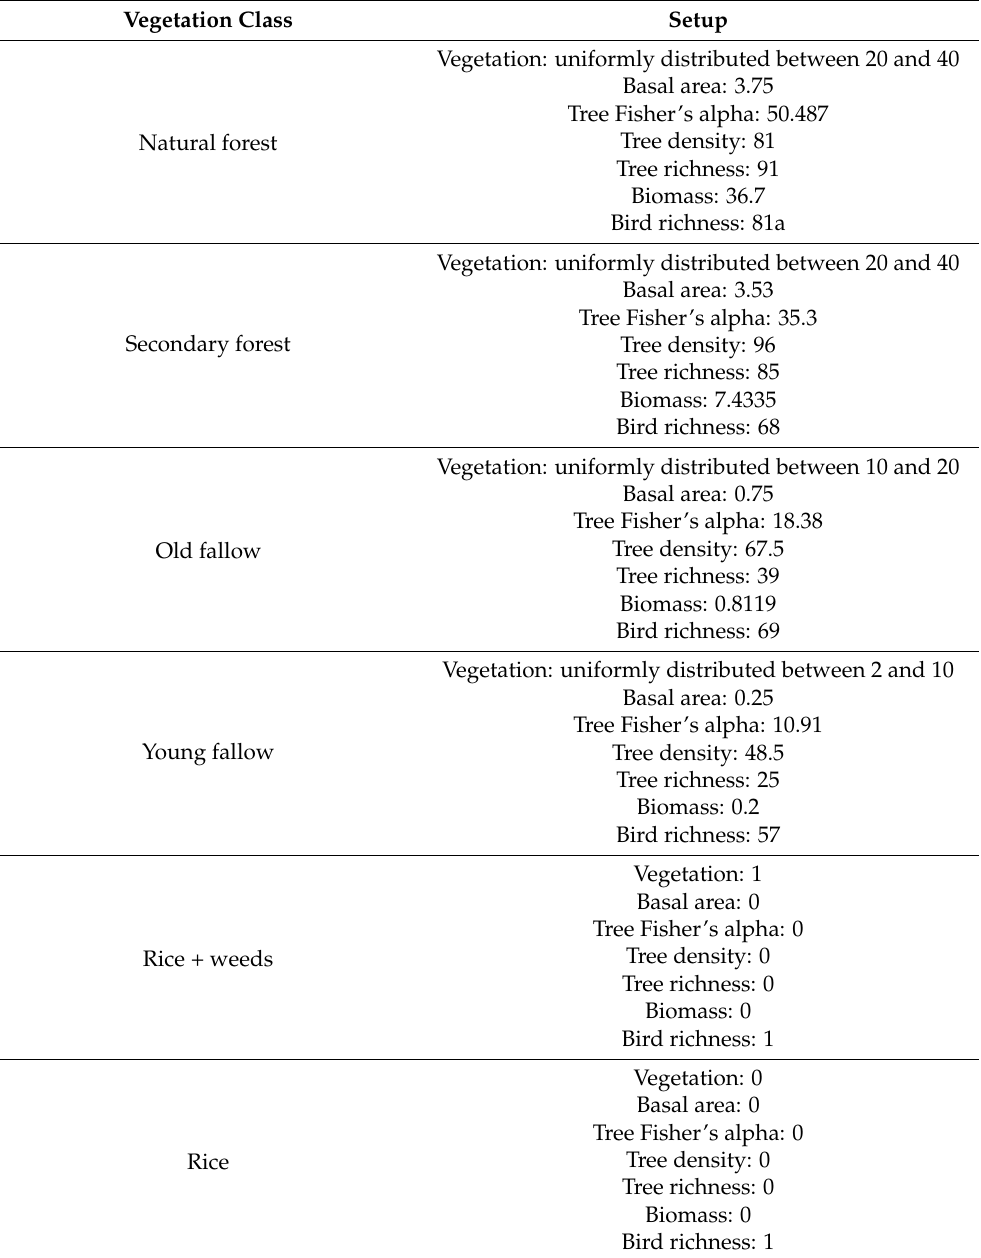
Table 3. Model description: landscape agents’ setup. Vegetation Class Setup